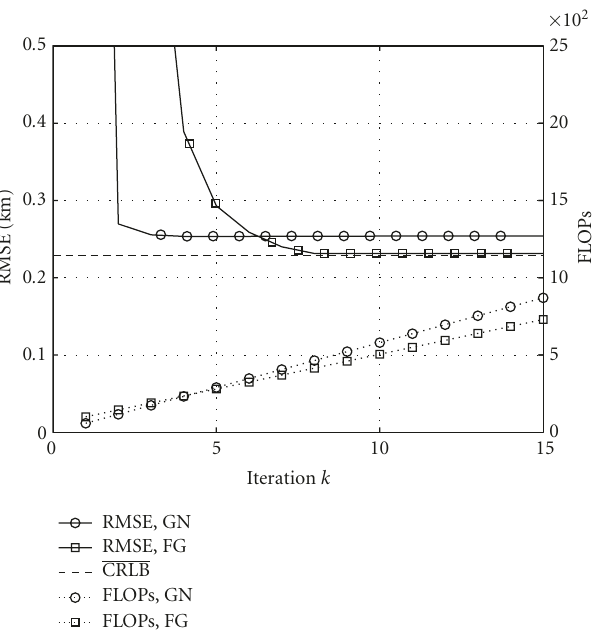
Figure 10: RMSE and FLOPs versus iterations for σ n = 0 . 2km, R = 3 km, N BS = 3.